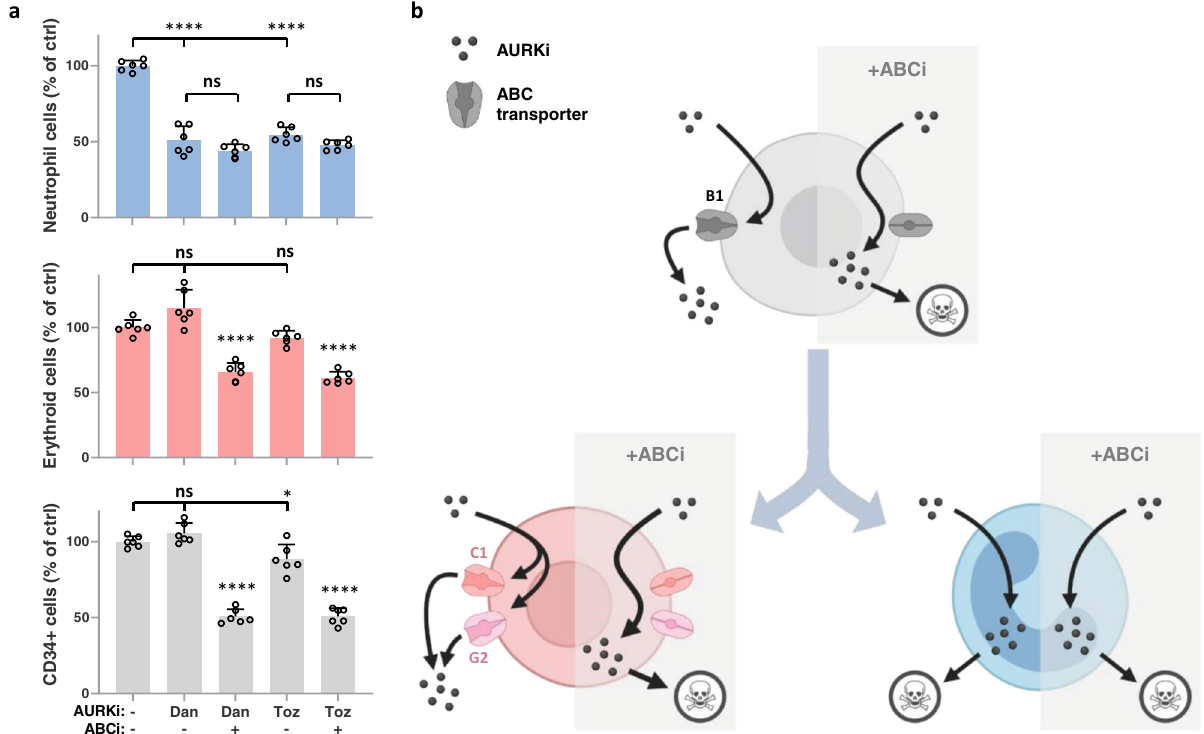
Fig.6|Neutrophil-biasedhematotoxicityformultipleAURKidrugsisdrivenby ABC transporter function. a Human CD34 + progenitor cells were cultured